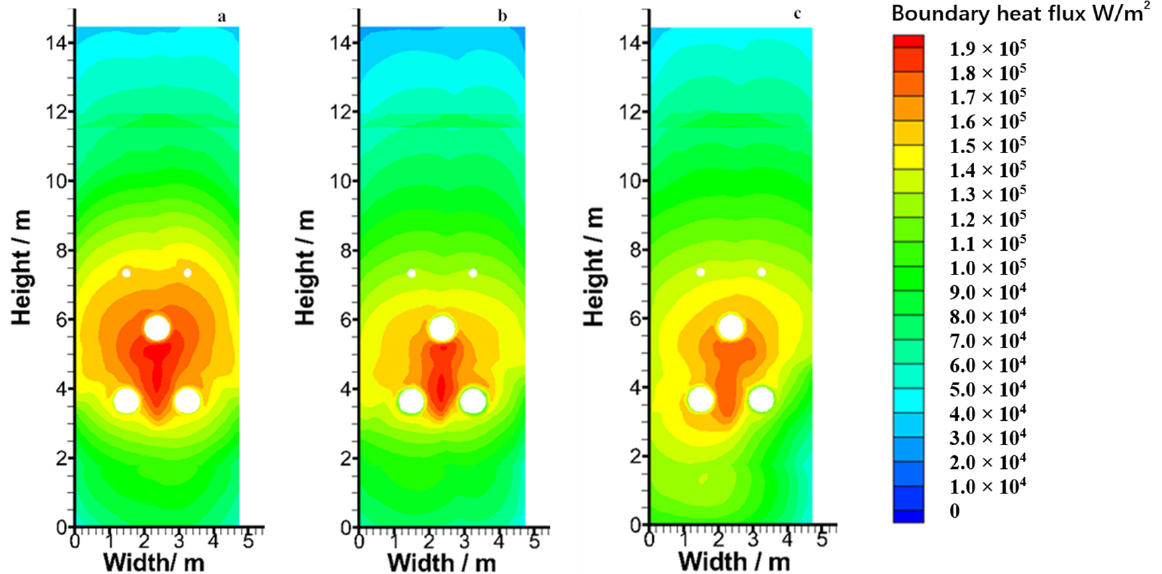
Figure 3. Distributions of heat flux in the front wall: ( a ) case 7, ( b ) case 8; and ( c ) case 9.